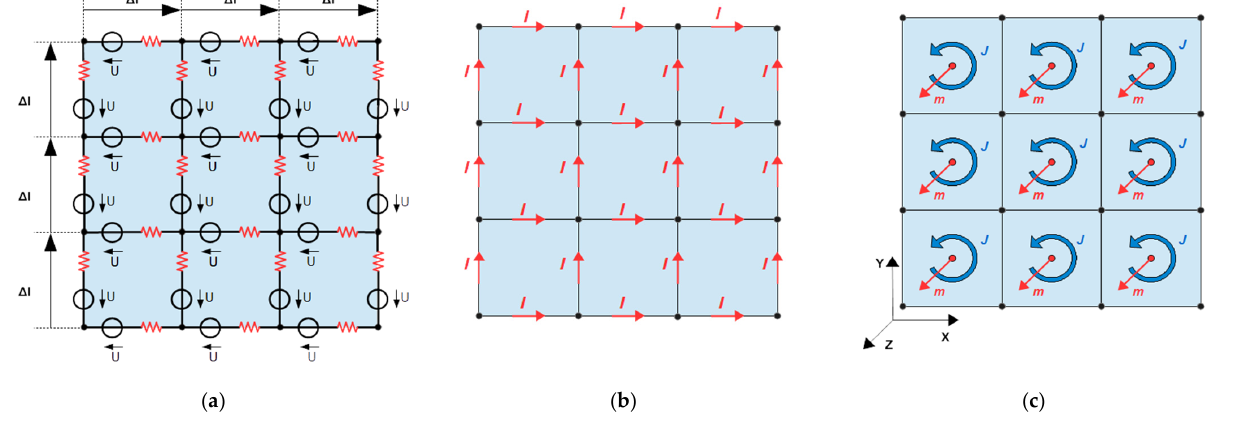
Figure 4. The discretized 2D object: ( a ) Representative electrical network with induced voltages; ( b ) The resulting eddy current field is represented by discrete current elements; ( c ) Magnetic moments point in the z-direction and represent localized and isolated current circulations, i.e., the eddy field ( b ) is decomposed into independent elements. Superposition of all elementary vortices results in the global eddy field in ( b ). Note that the number of sufficiently describing moments (here, 9) is smaller than the number of non-independent currents (here, 24) in ( b ).